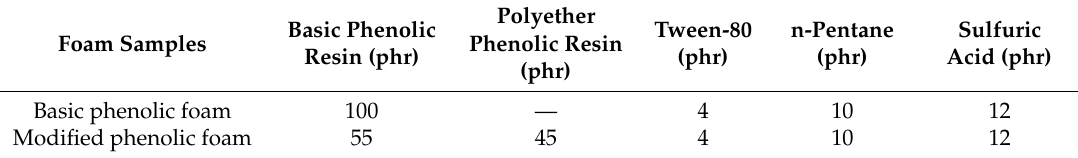
Table 2. The phenolic resin foaming